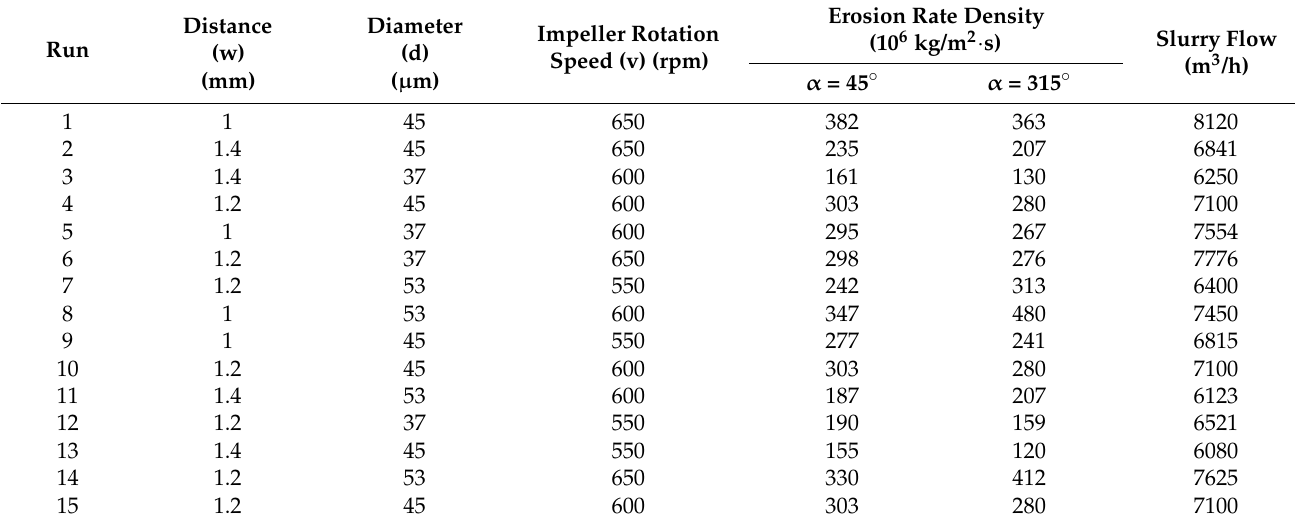
Table 4. Results of experimental and predicted